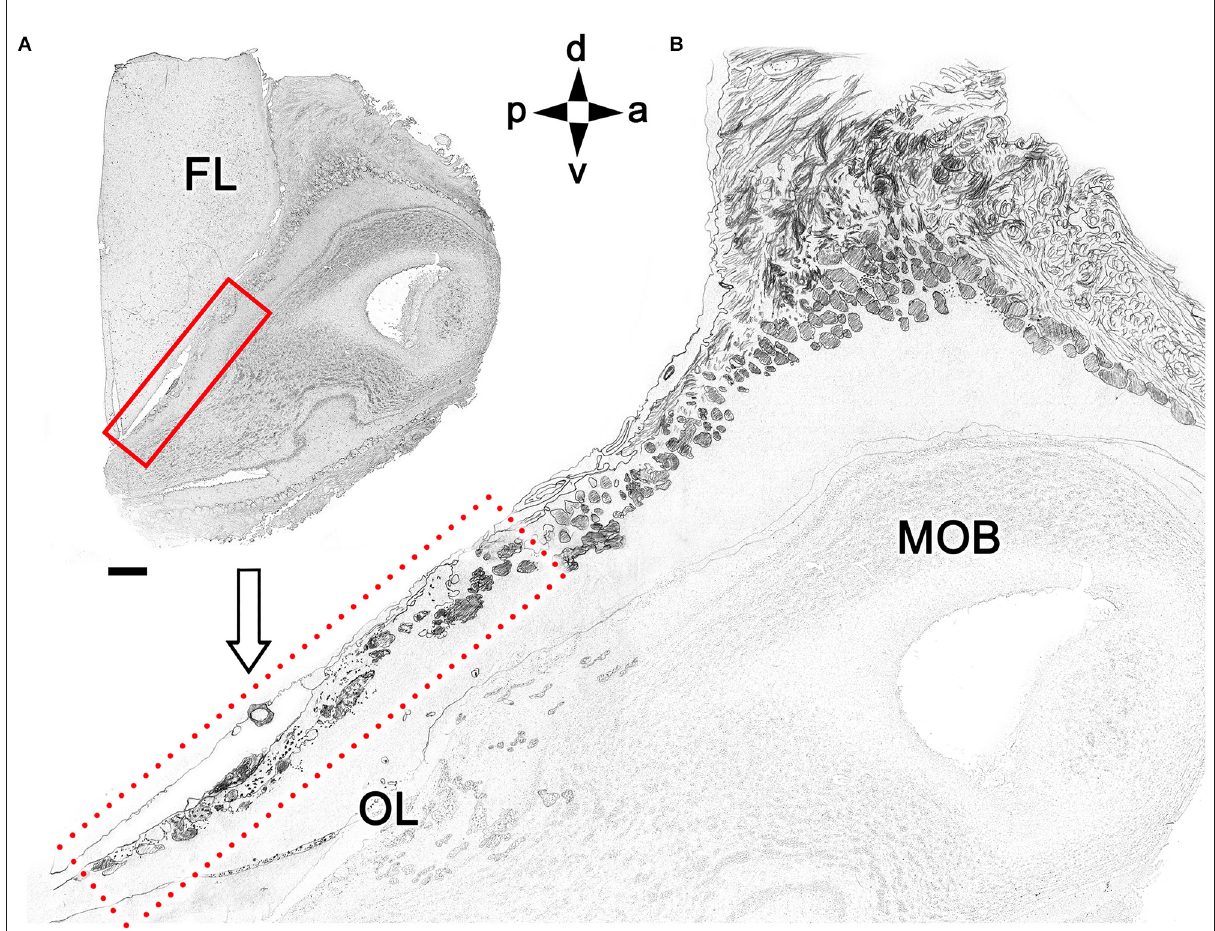
FIGURE6 Schematic drawing of a sagittal histological section of the olfactory bulb. (A) Magnification of the area corresponding to the OL (box in B ). Orientation: m, medial; l, lateral; p, posterior; a, anterior. Scale bar: 500 µ m.